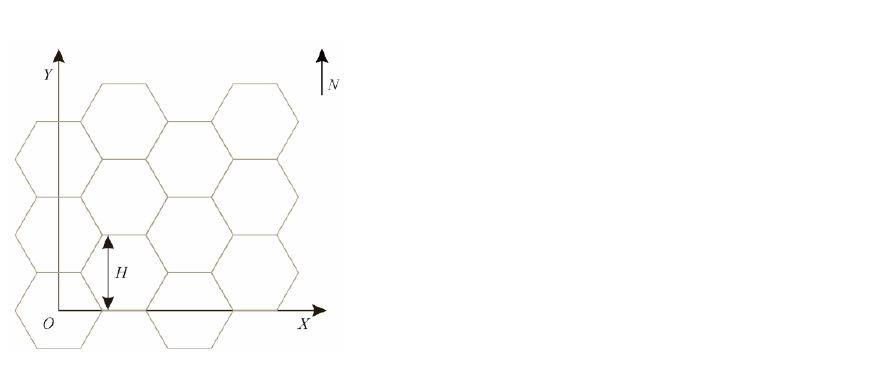
Figure 8. Schematic diagram of grid size, starting point and orientation